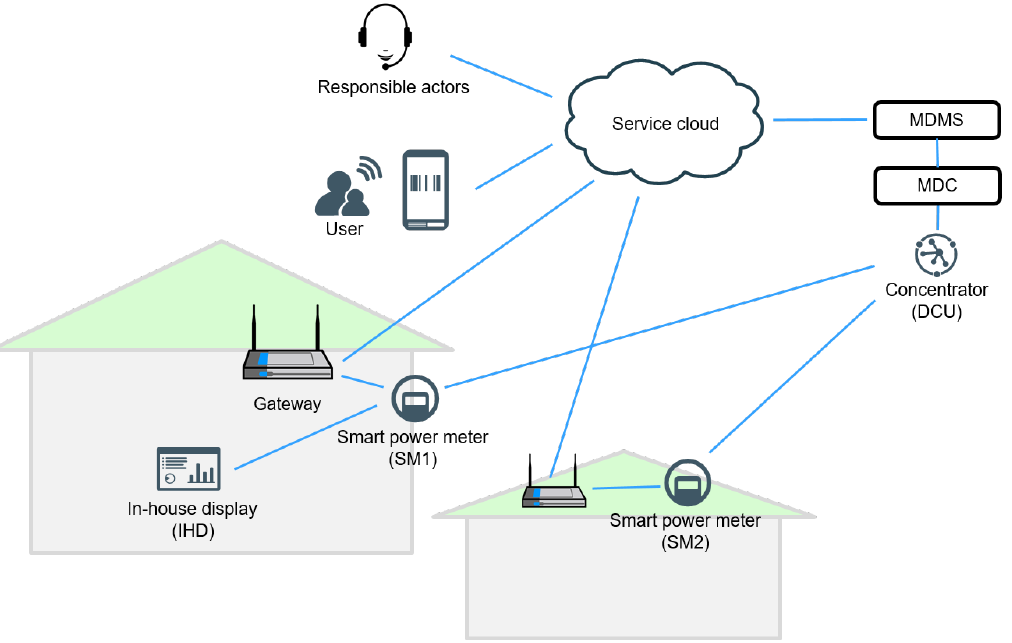
Figure 9. Smart home and smart meter hijacking use-case